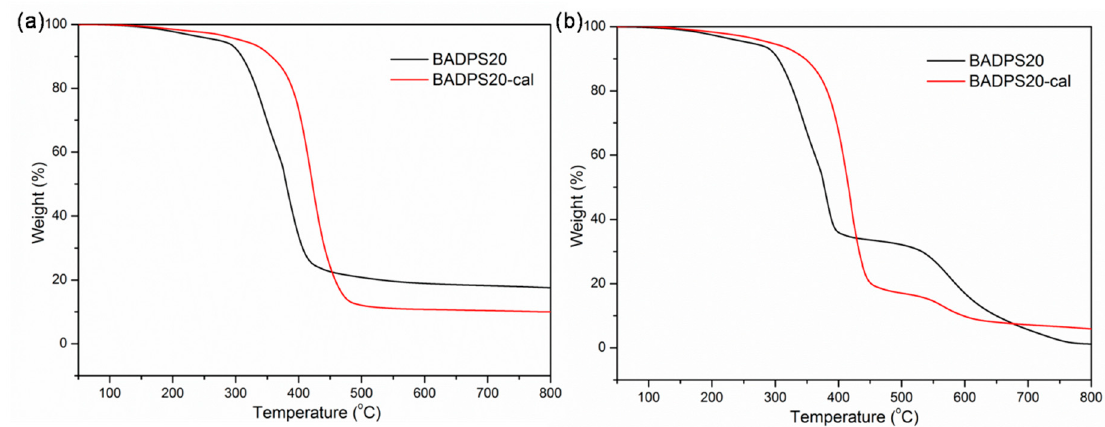
Figure 6. Experimental and theoretical TG curves of BADPS20 in ( a ) N 2 atmosphere and ( b ) air.